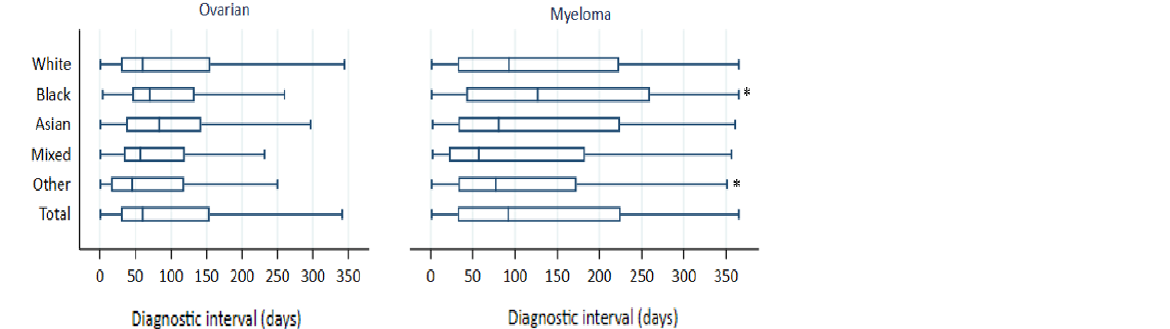
Figure 1. Site-specific box and Whisker plots showing ethnic differences in the number of days to diagnosis (lower adjacent value, 25th, 50th, and 75th centiles, and upper adjacent value). Figures are the exact number of days from index feature to diagnosis. Asterisks indicate significant ethnic differences in DI compared with the White group: (** p -value ranges from 0.001 to 0.004) (* p -value ranges from 0.01 to 0.05).